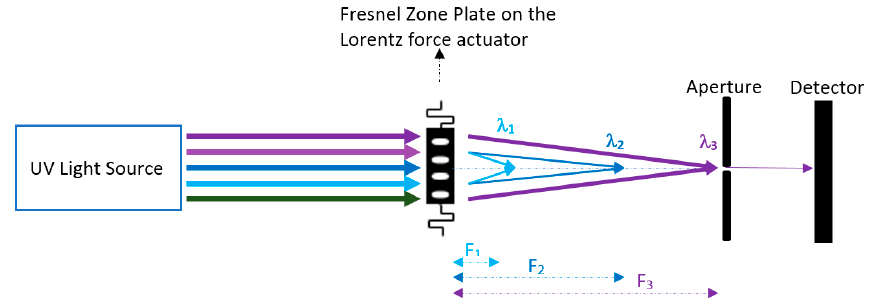
Figure 1. The FZP is placed on top of a MEMS actuator which moves horizontally. F 1 , F 2 , and F 3 are the focal lengths of λ 1 , λ 2 , and λ 3 respectively. By moving the FZP the desired wavelength can be focused on the detector.